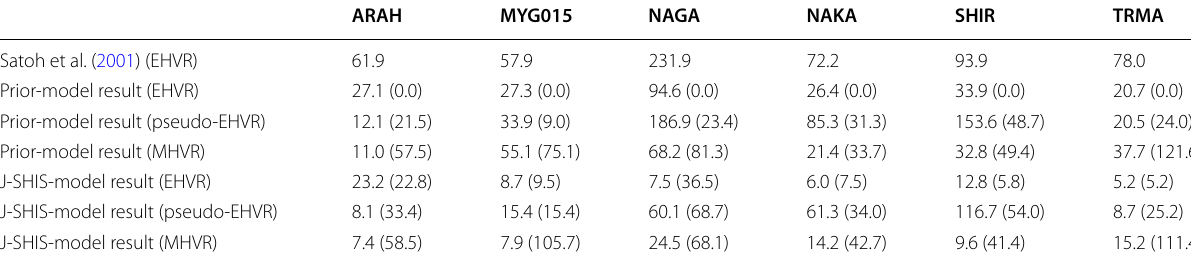
Table 6 Comparison of the final residuals in the inversions ARAH MYG015 NAGA NAKA SHIR TRMA Satoh et al. (2001)